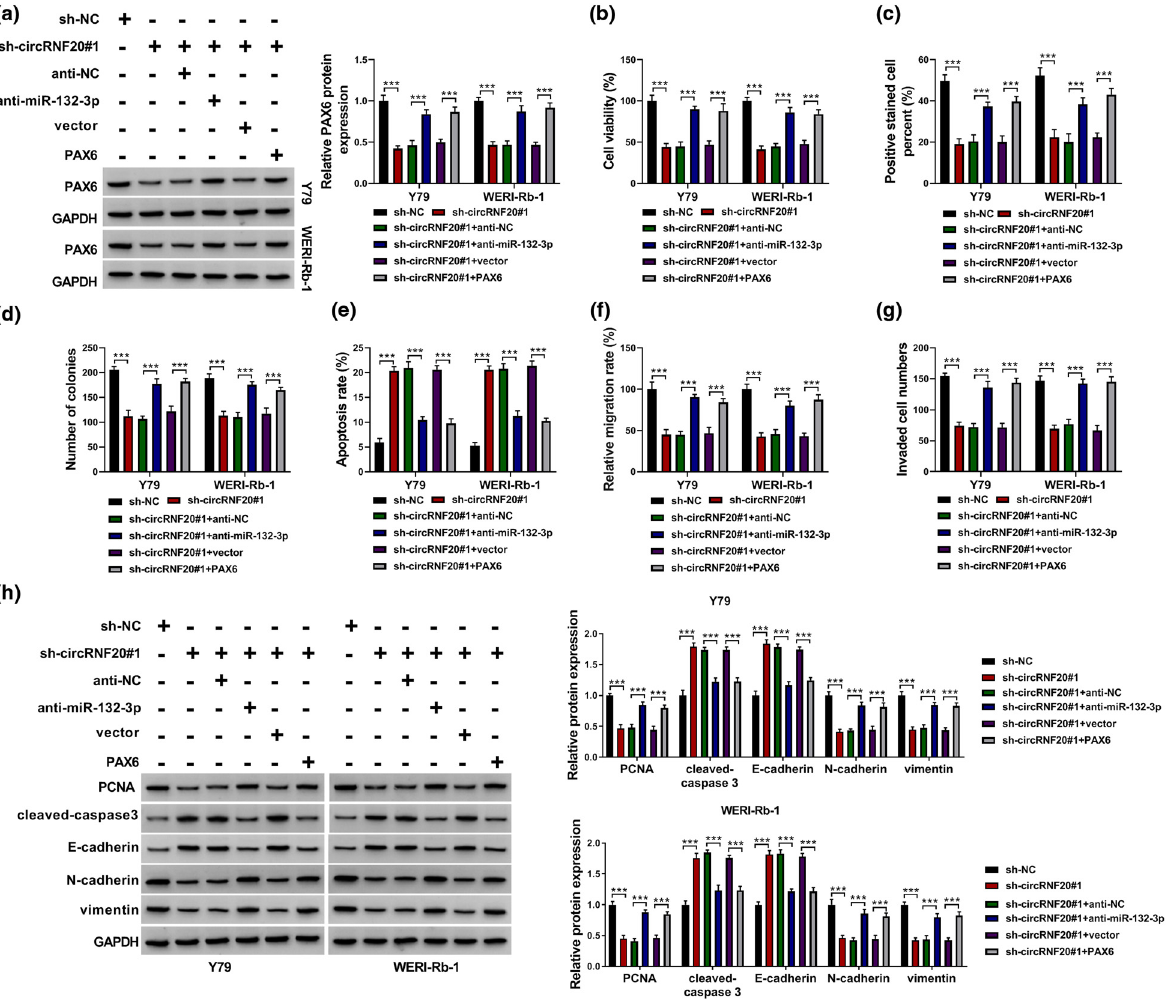
Figure 6: circRNF20 regulated RB cell malignant behaviors by miR - 132 - 3p and PAX6. Sh - NC, sh - circRNF20#1, sh - circRNF20#1 + anti - NC, sh - circRNF20#1 + anti - miR - 132 - 3p, sh - circRNF20#1 + vector or sh - circRNF20#1 + PAX6 was transfected into Y79 and WERI - Rb - 1 cells. ( a ) The protein level of PAX6 in Y79 and WERI - Rb - 1 cells was examined by qRT - PCR assay. ( b – d ) The viability, proliferation and colony formation of Y79 and WERI - Rb - 1 cells were tested by CCK - 8 assay, EDU assay and colony formation assay. ( e ) The apoptosis of Y79 and WERI - Rb - 1 cells was analyzed by fl ow cytometry analysis. ( f and g ) The migration and invasion of Y79 and WERI - Rb - 1 cells were assessed by wound - healing assay and transwell assay. ( h ) The protein levels of PCNA, cleaved - caspase 3, E - cadherin, N - cadherin and vimentin in Y79 and WERI - Rb - 1 cells were measured by western blot assay. *** P <